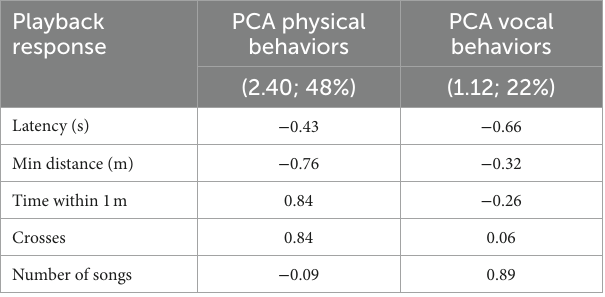
TABLE 2 Factor loadings from principal component analysis (PCA) of the small ground finches’ responses to playback ( n = 82